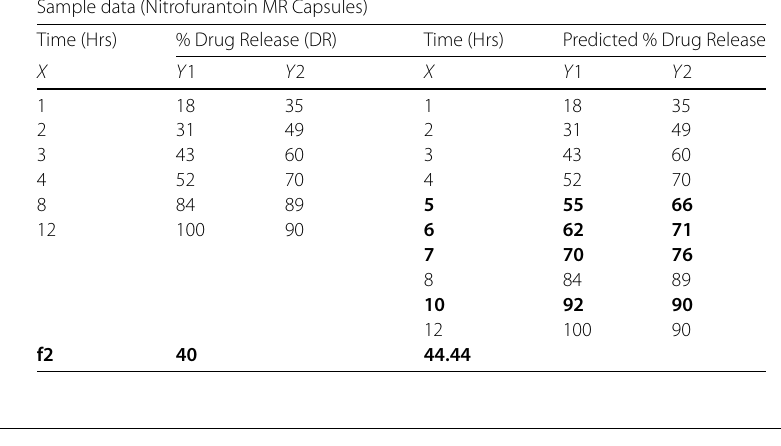
Table 2 Comparison of two drug release profiles of Nitrofurantoin MR Capsules Sample data (Nitrofurantoin MR Capsules)